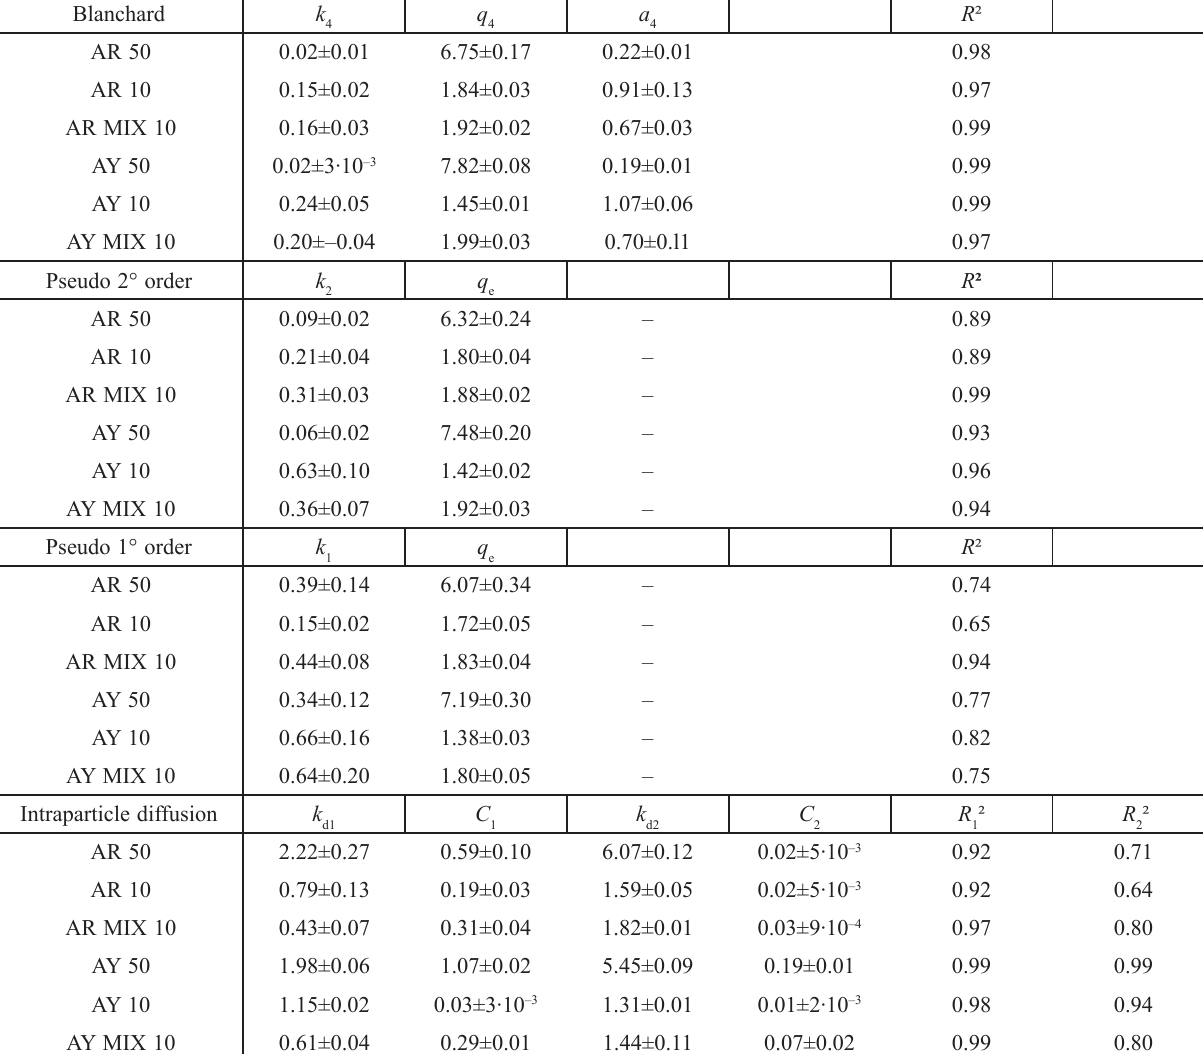
Table 3 – Kinetic parameters for the biosorption of acid yellow and acid red dyes in Açaí seeds powder acid